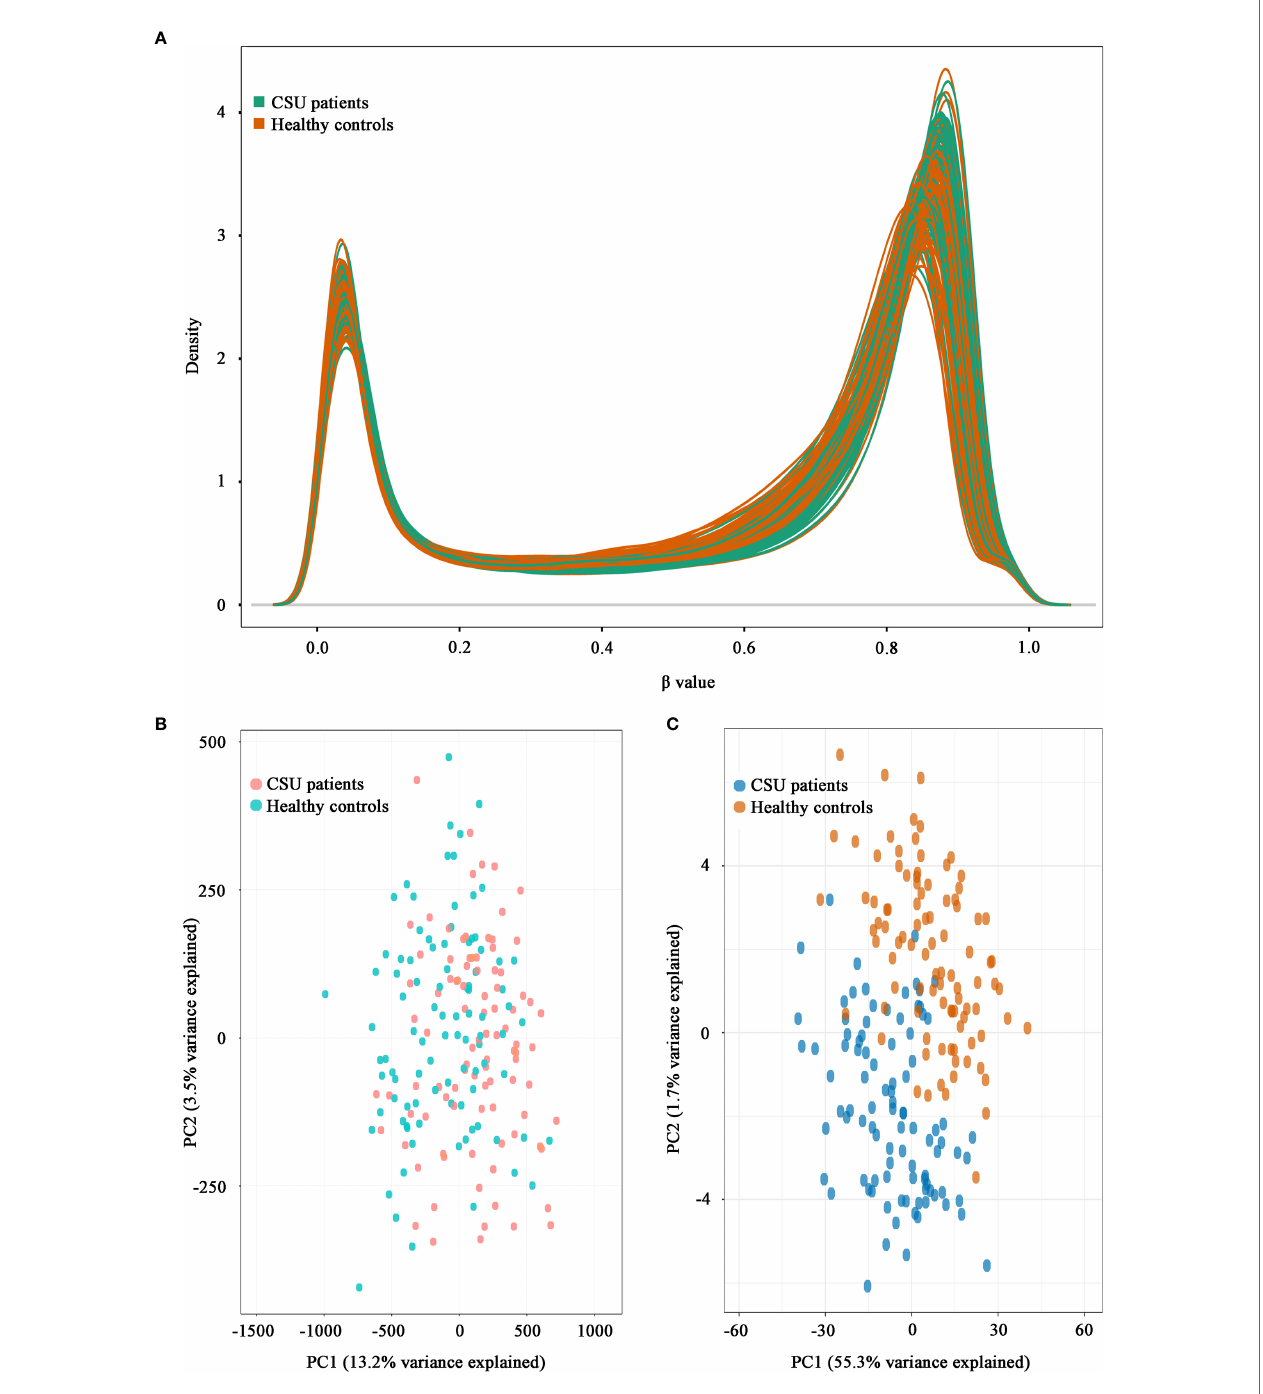
FIGURE 1 | Density plot and principal component analysis (PCA) plot. (A) Density plot. The methylation levels of the 95 CSU patients (green lines) and the 95 healthy controls (red lines) are expressed as b values. (B) PCA plot based on all 832,347 CpG sites. No discernable separation is observed between the CSU patients (red dots) and the healthy controls (green dots). PC1, principal component 1 (13.2% variance explained); PC2, principal component 2 (3.5% variance explained). (C) PCA plot based on 439 differentially methylated positions (DMPs). Two different clusters are observed between the CSU patients (blue dots) and the healthy controls (red dots). PC1, principal component 1 (55.3% variance explained); PC2, principal component 2 (1.7% variance